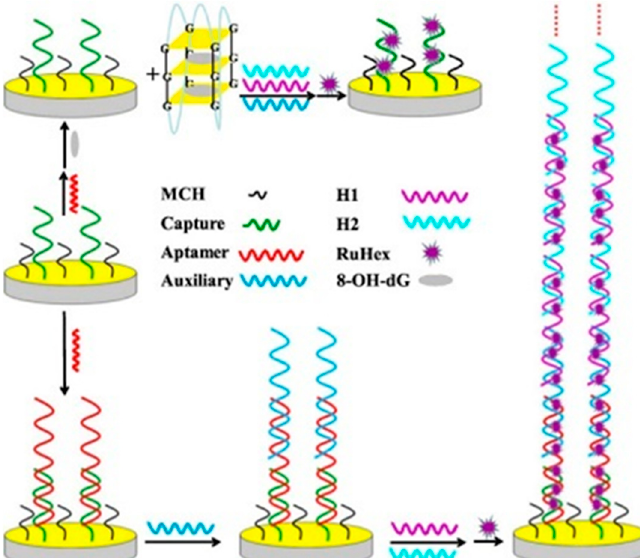
Figure 6. An aptamer-based electrochemical biosensor with hybridization chain reaction (HCR) signal amplification for the detection of o 8 dGuo. Reprinted with permission from Reference [34]. © 2018, Elsevier.